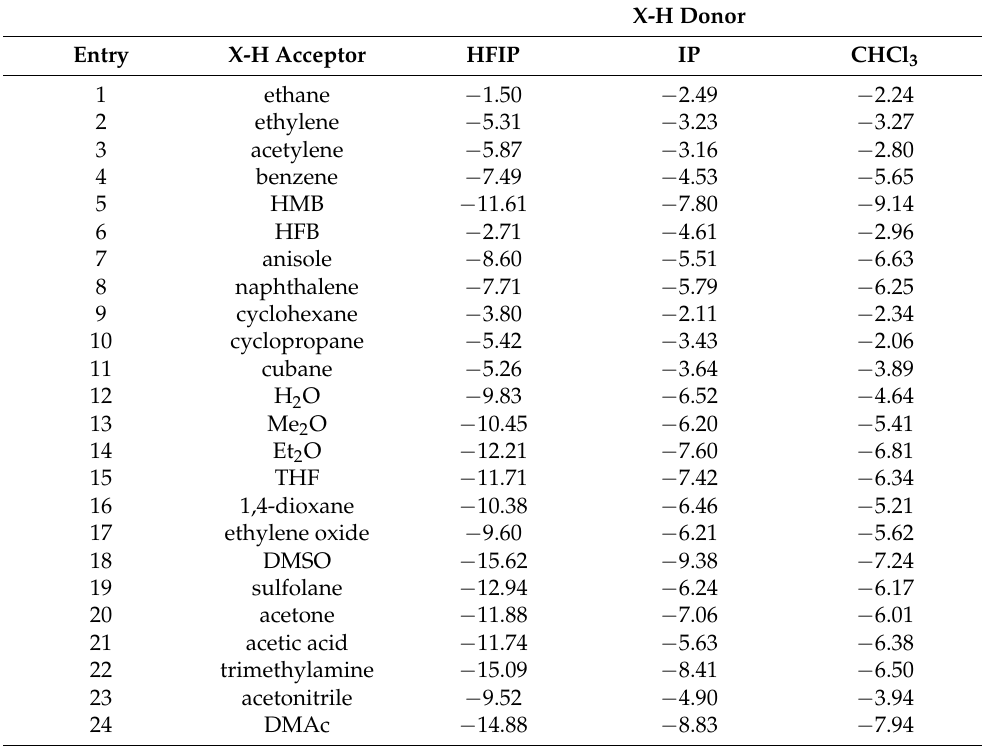
Table 2. Interaction energies of HFIP, isopropanol (IP), and chloroform (CHCl 3 ) between